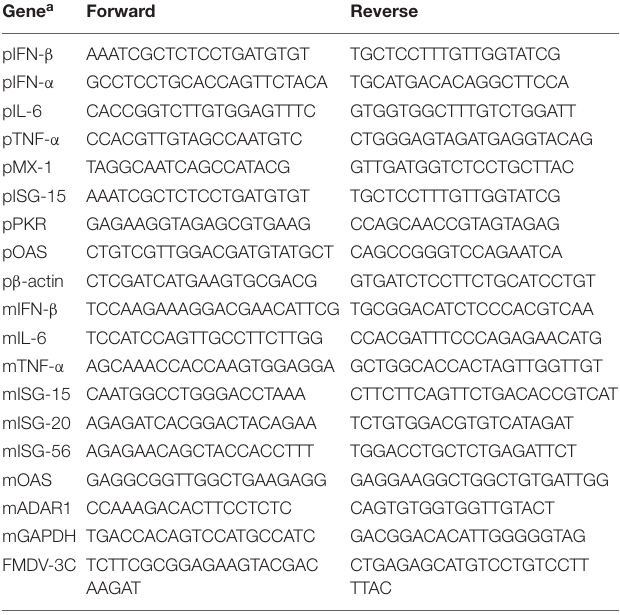
TABLE 1 | Primers for